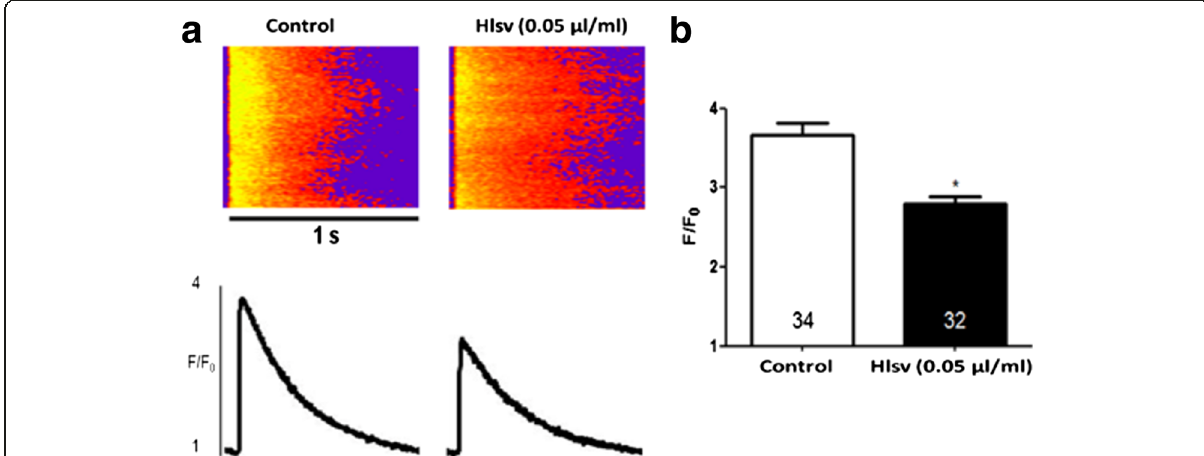
Fig. 6 Cardiomyocytes exposed to Hlsv display reduced Ca 2+ transient amplitude. a ( Top ) Representative confocal images of electrically stimulated intracellular Ca 2+ transient recordings in ventricular myocytes. ( Bottom ) Ca 2+ transient line-scan profile. b Significant reduction in peak Ca 2+ transient amplitude was observed in freshly isolated adult ventricular myocytes incubated with 0.05 μ g/mL of Hlsv venom for 5 to 20 min. Numbers inside the bars (34 in the control group and 32 in the in the treated group) represent the number of cells analyzed. Data are expressed as mean ± SEM, * p < 0.0001 compared to